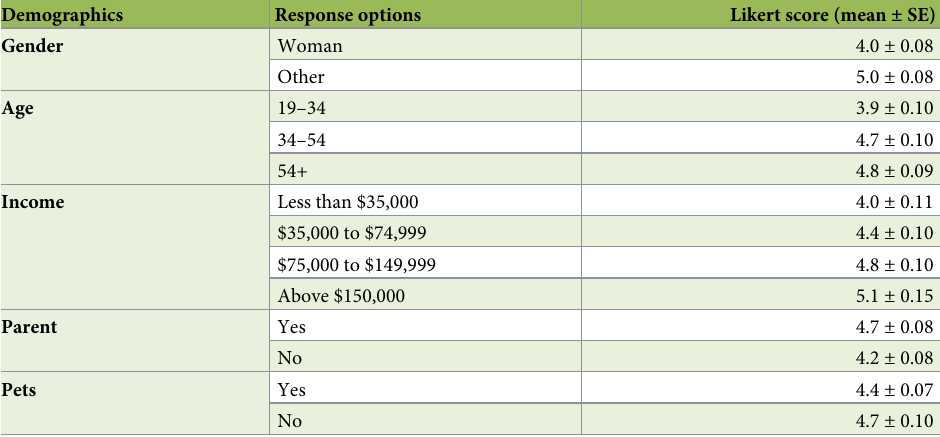
Table 3. Participant (n = 1521) score by demographic questions known to influence the support of animal research after responding to one of the five research